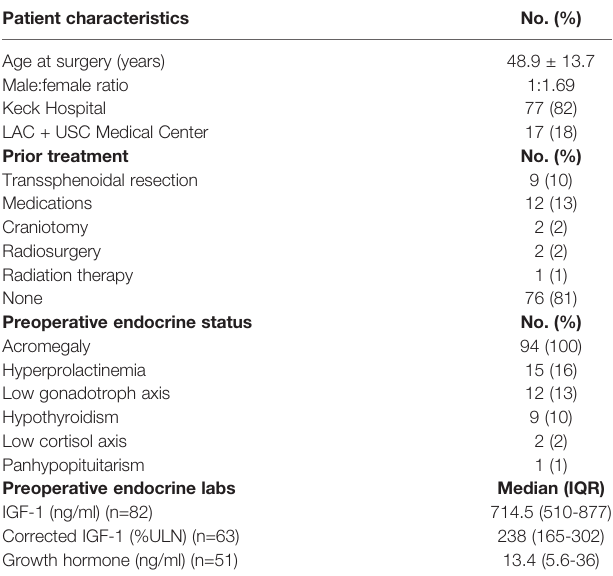
TABLE 1 | Presenting patient characteristics, prior treatment, and endocrine status and lab